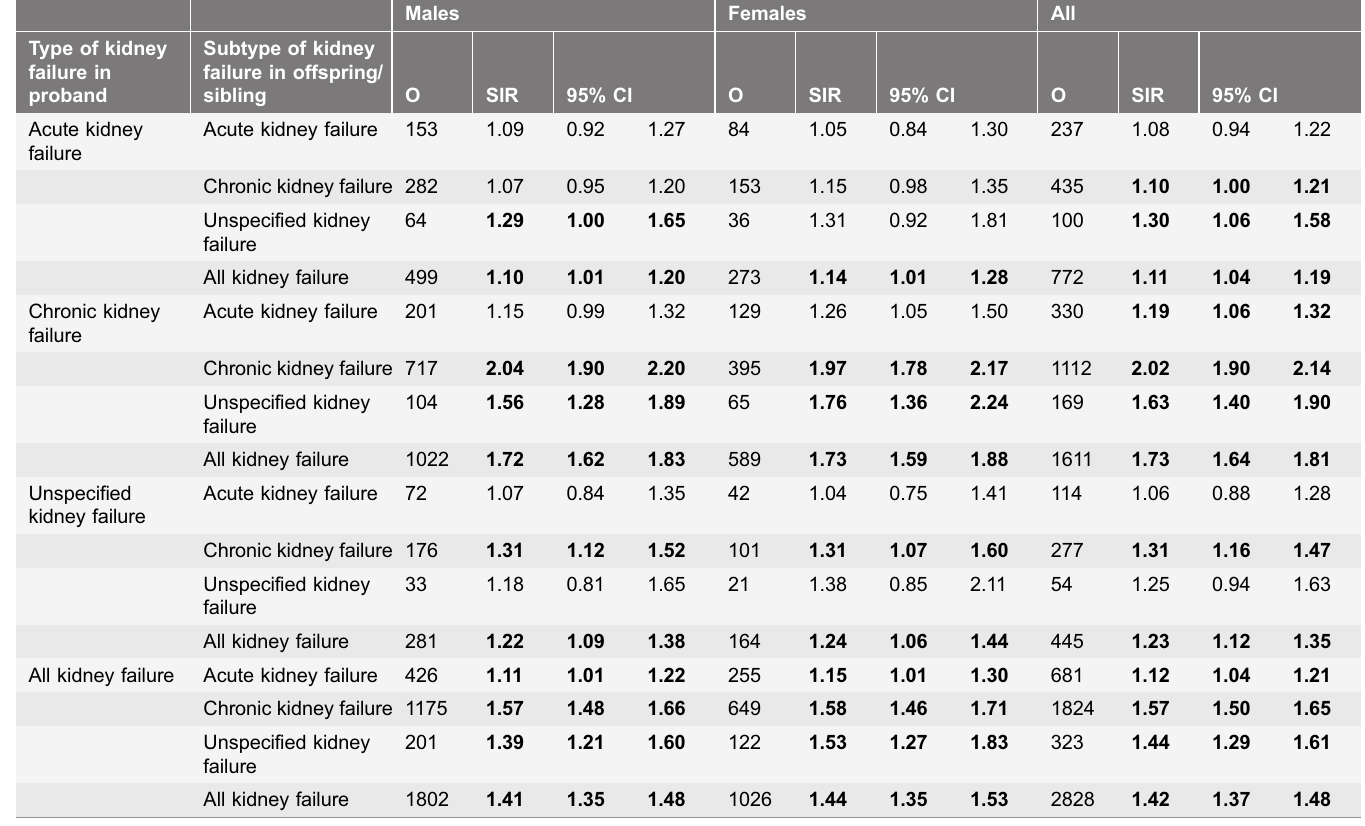
Table 2. Familial concordant and discordant risk (sibling/parent history) of kidney failure in males and